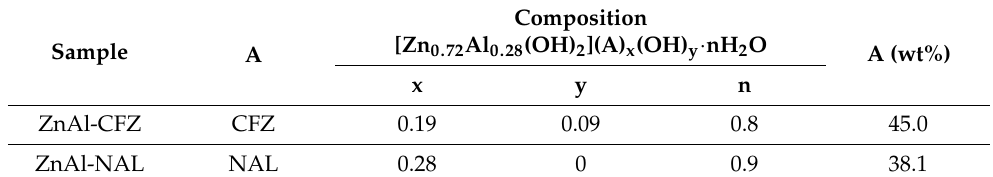
Table 1. Sample acronym, composition, and weight percentage of antibiotic (A) loaded.